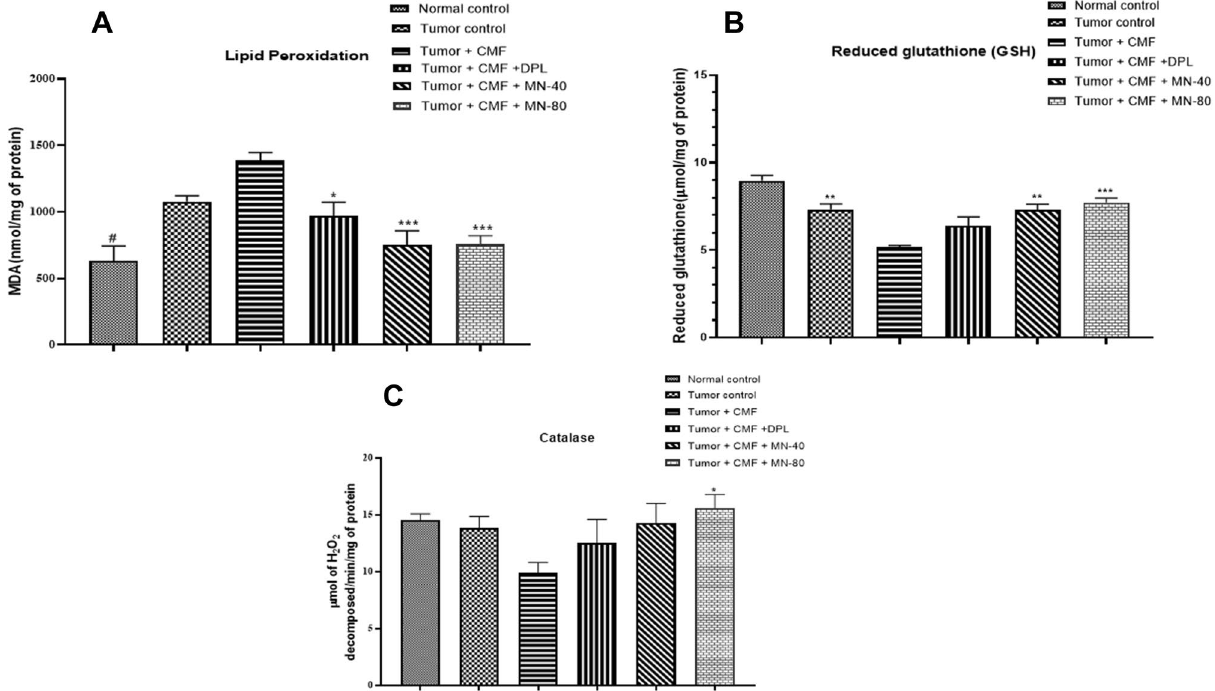
Figure 8. Effect of Mulmina (MN), Cyclophosphamide + Methotrexate + 5-Fluorouracil (CMF), Donepezil (DPL) on ( A ) LPO ( B ) GSH ( C ) Catalase on tumor-bearing animals. Values are expressed as mean ± SEM (n = 3–4). Statistical analysis was done by using one-way anova followed by Dunnet’s post-hoc test .* p < 0.05,** p < 0.01, *** p < 0.001 compared to tumor + CMF treated group. #p < 0.05 compared to tumor control group analysed by unpaired student ’t’ test.